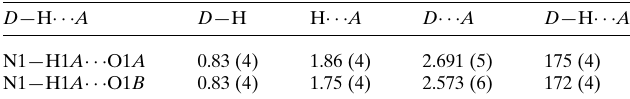
Table 1 Hydrogen-bond geometry (A˚ , (cid:5) ).